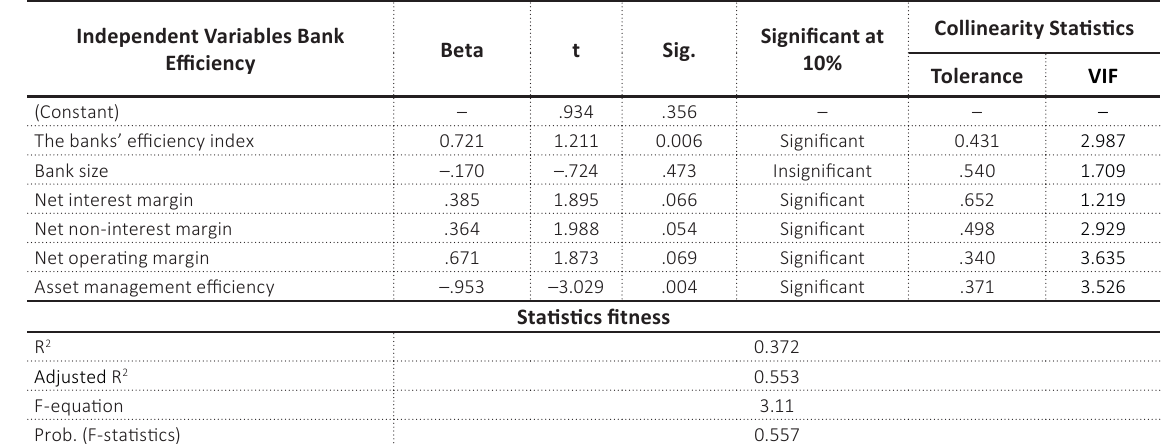
Table 14. Analysis output for Model